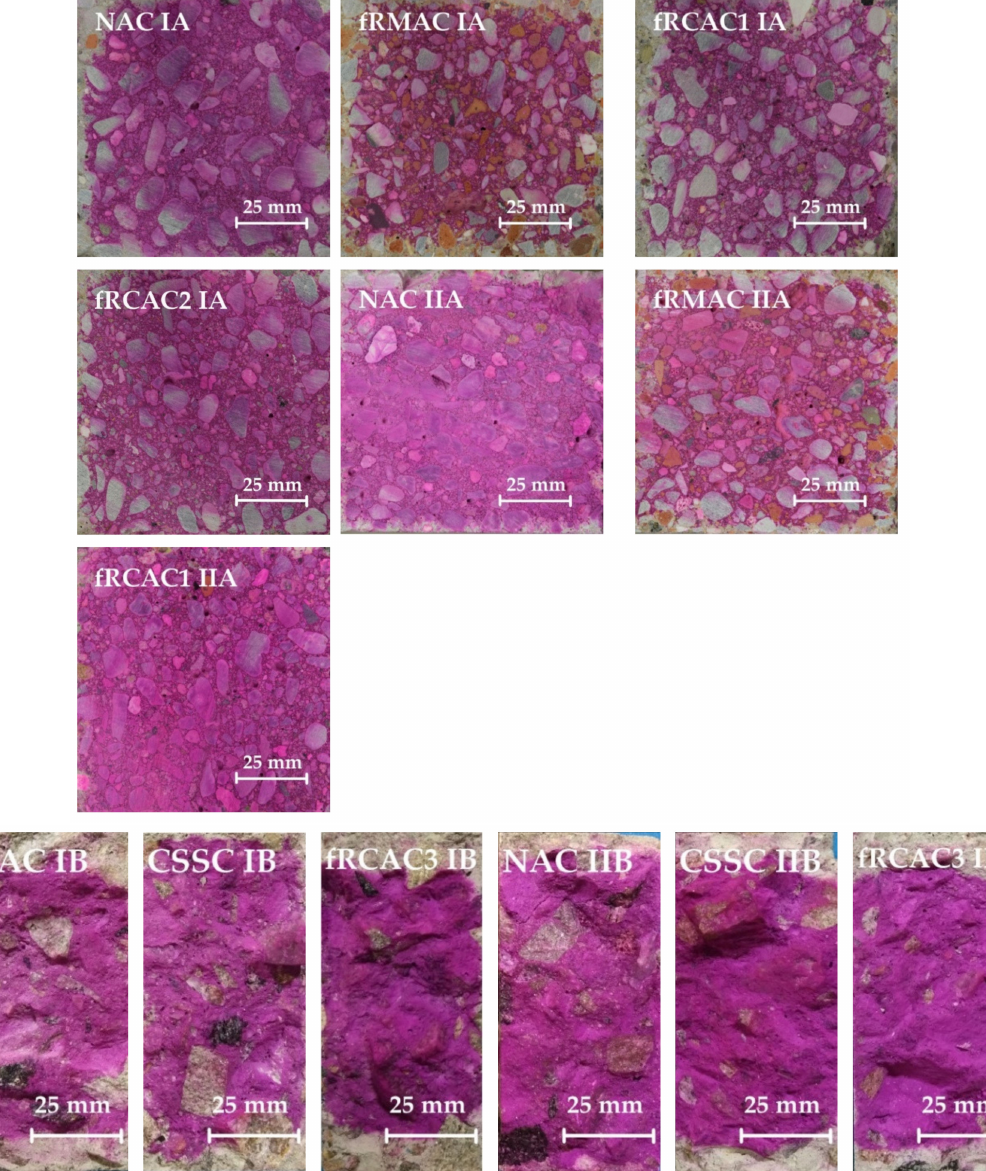
Figure 12. Carbonation depth of NAC and